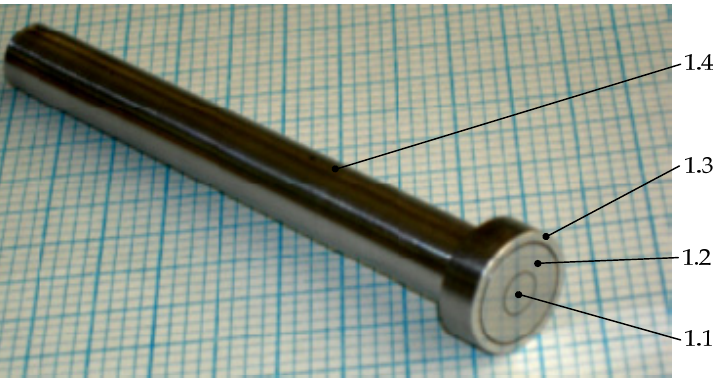
Figure 13. Prototype of type 2 sensor: 1.1—potential electrode, 1.2—guard electrode, 1.3—ground, 1.4—sensor body.